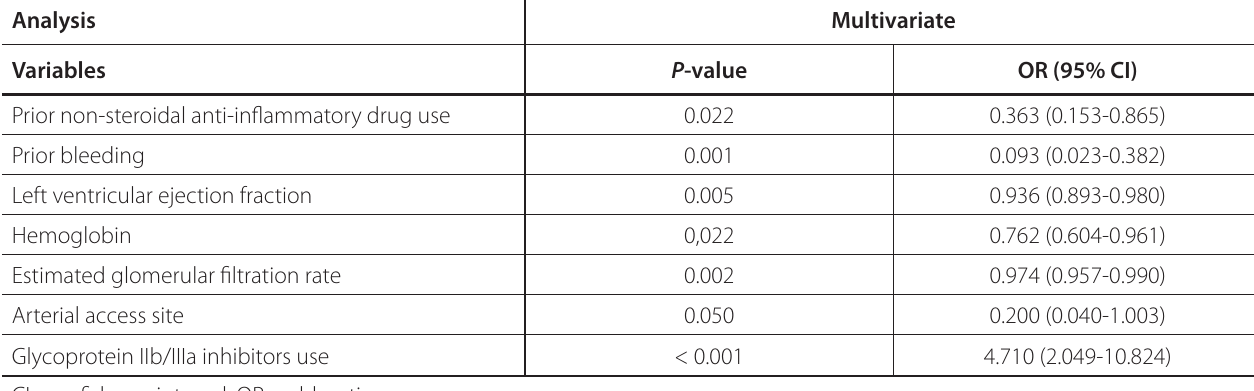
Table 4. In the multivariate logistic regression analysis, non- steroidal anti-inflammatory medication history (xv=0.022), prior bleeding ( P =0.001), left ventricular ejection fraction (v=0.005), hemoglobin ( P =0.022), eGFR ( P =0.002), arterial access site ( P =0.05), and glycoprotein IIb/IIIa inhibitors use ( P <0.001) were independent predictors of bleeding in all study population. Table 4 . Multivariate logistic regression analysis for predictors of bleeding events.